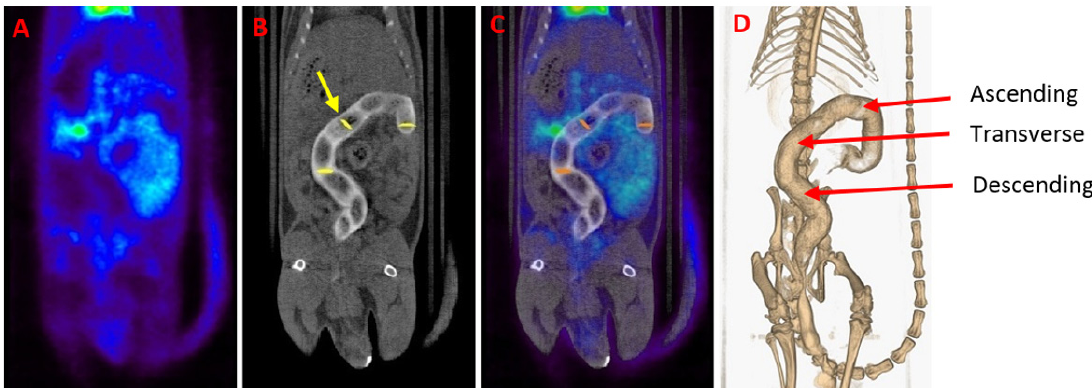
Figure 5. ( A ) Gastrointestinal PET image of a healthy animal. ( B ) CT scan of the same animal. A contrast agent was used for enhancing contrast in the colon of the animal (white color). The yellow arrow indicates one of the circularly delineated regions of interest (ROIs). ( C ) [ 18 F]FDG PET/CT image obtained by the fusion of (A) and (B) images. Notice the normal [ 18 F]FDG uptake in the heart, bladder and kidneys. ( D ) Three-dimensional colon reconstruction from CT images with the three colonic sections indicated by the red arrow (ascending, transverse and descending).